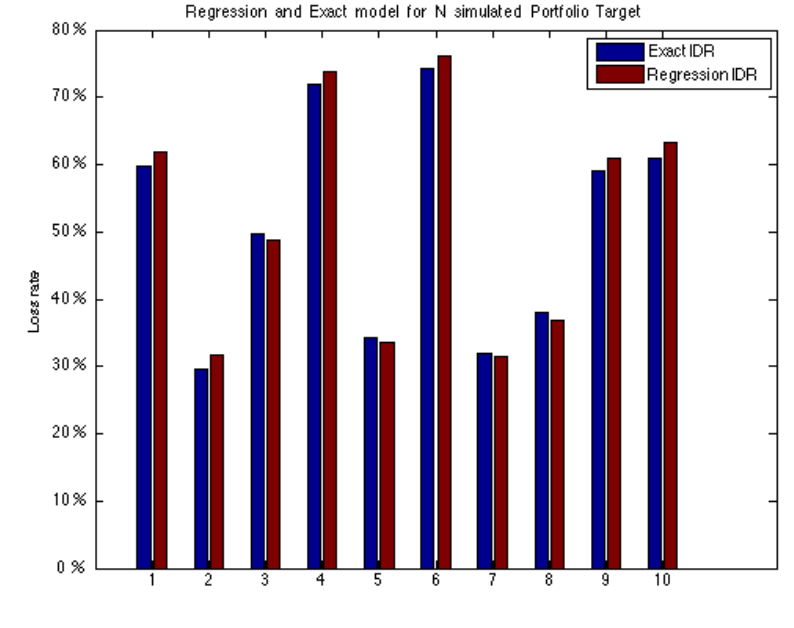
Figure 10: Histogram of the comparison between the values obtained with the exact algorithm and the HR model.